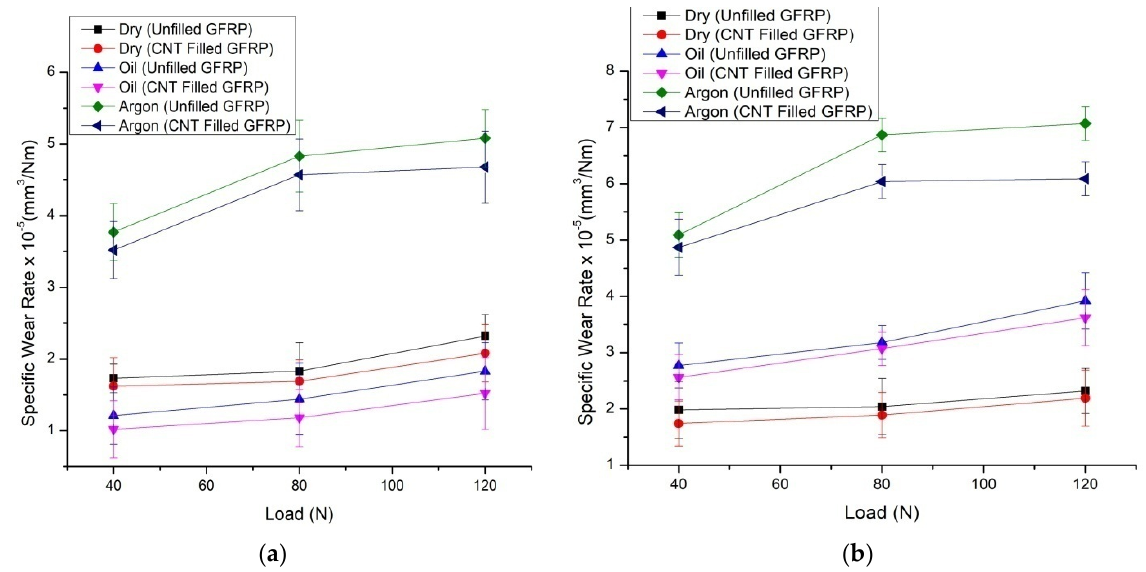
Figure 4. ( a ) Specific wear rate v/s Load for CNT filled GFRP and unfilled GFRP composites, during all the three environmental conditions at 2.51 m/s and for 1508 m, and ( b ) Specific wear rate v/s Load for CNT filled GFRP and unfilled GFRP composites, during all the three environmental conditions at 3.14 m/s and for 2828 m.